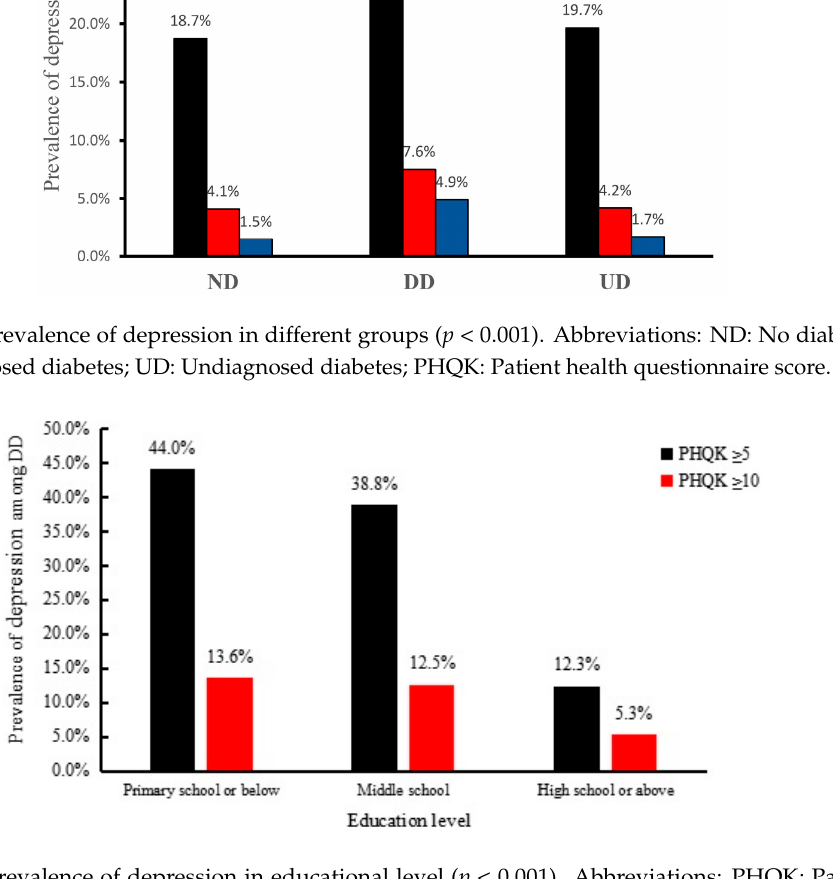
Figure 2. Prevalence of depression in educational level ( p < 0.001). Abbreviations: PHQK: Patient health questionnaire score; DD: Diagnosed diabetes.